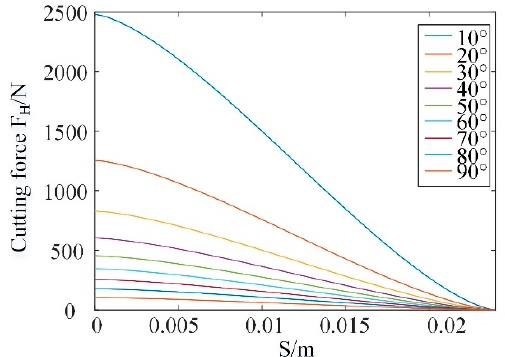
Figure 12. The cutting force Fc with the blade displacement from 0 to 0.024 m and the rake angle from 10° to 90°.